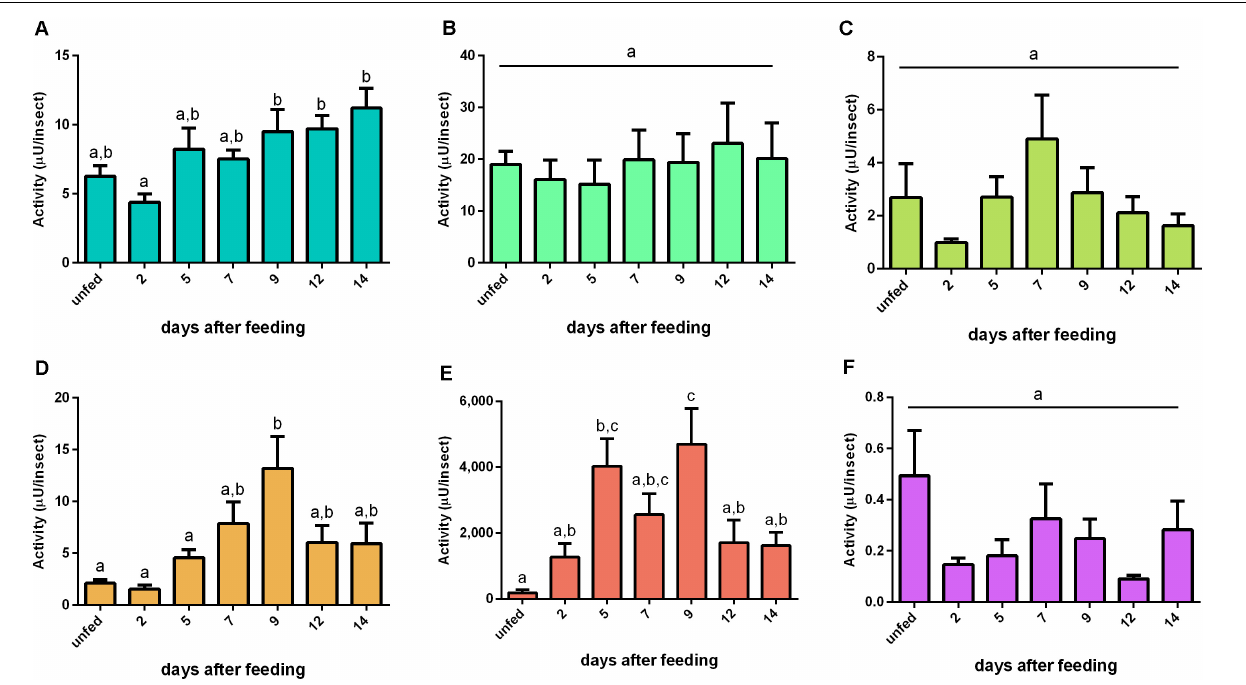
FIGURE 4 | Cathepsin L-like activity ( µ U per insect), using Z-Phe-Arg-AMC as substrate, in the different digestive compartments (tissues and luminal contents) of Rhodnius prolixus male adults, unfed and at 2, 5, 7, 9, 12, and 14 daf on defibrinated rabbit blood, assayed in 0.2 M citrate-phosphate buffer, pH 5.5. (A) Anterior midgut tissues. (B) Posterior midgut tissues. (C) Hindgut tissues. (D) Anterior midgut contents. (E) Posterior midgut contents. (F) Hindgut contents. Figures are means ± SEM ( n = 9). In a dataset, groups with the same superscript letter are not significantly different ( p > 0.05). Statistical analysis consisted of ordinary one-way ANOVA with Tukey’s multiple-comparisons test. Consider different scalings of